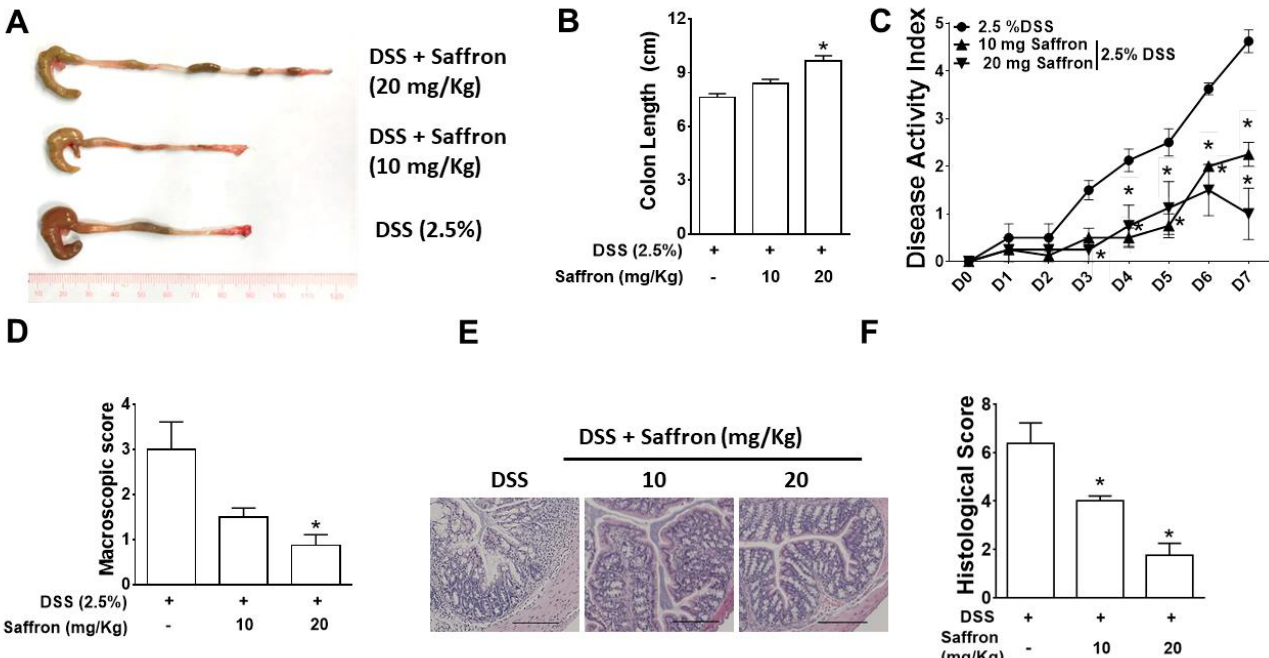
Figure 1. Saffron reduced the severity of DSS-induced colitis in mice. Mice were orally gavaged with saffron (10 mg/Kg and 20 mg/Kg) or the vehicle for 4 days before the administration of 2.5% DSS in their drinking water and continued for 7 days along with the DSS. Inflammation was assessed by ( A ) macroscopic appearance of the colon tissue; ( B ) colon length; ( C ) the disease activity index; ( D ) the macroscopic score; ( E ) representative micrographs of H&E-stained colon cross-sections on day 7 post-DSS, bar = 100 µM; and ( F ) the histological score. Data represent the mean ± SEM ( n = 4/group). * p < 0.05, compared to the vehicle-treated mice.